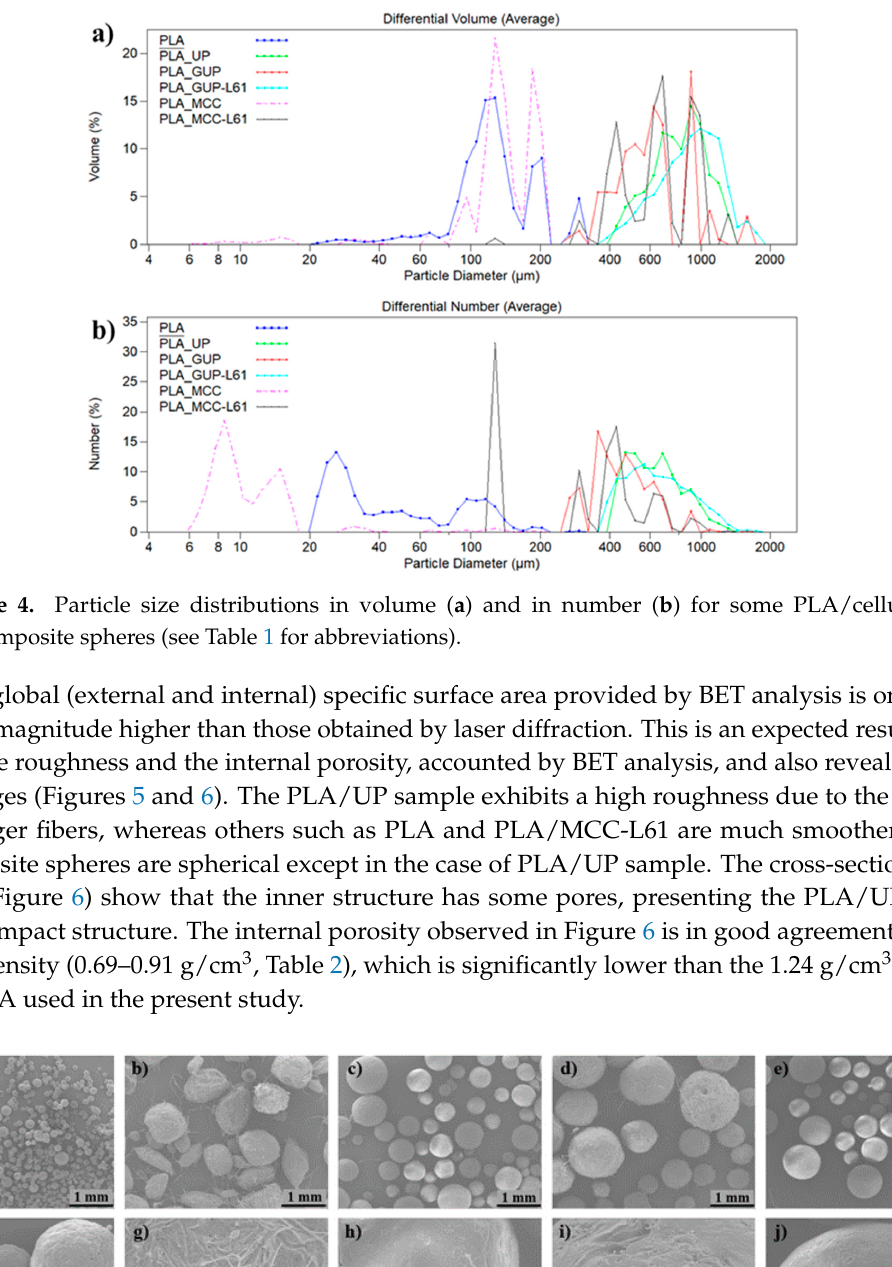
Figure 5. SEM images of the surface morphology of biocomposite spheres: ( a , f ) PLA; ( b , g ) PLA/UP); ( c , h ) PLA/GUP; ( d , i ) PLA/GUP-L61; ( e , j ) PLA/MCC-L61; ( a ) 200× and ( f ) 1000× magnification; ( b – e ) 25× and ( g – j ) 200× magnification (see Table 1 for sample identification).